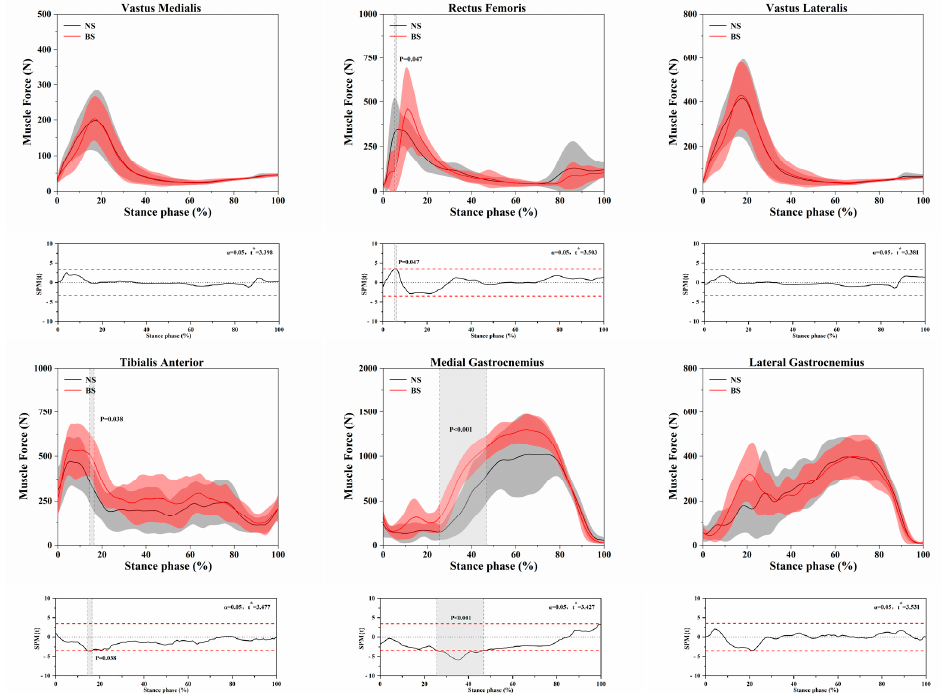
Figure 6. Illustration of the result between the NS and BS lower limb showing the statistical parametric mapping outputs for the medial gastrocnemius, lateral gastrocnemius, vastus medialis, vastus lateralis, rectus femoris, and tibialis anterior during the walking stance phase. The muscle force values of t* are shown on the left of each image. Grey shades represent the significant differences and the t -values of the SPM for all participants (post hoc results; dashed red lines represent the results at a p = 0.05 level). NSs, normal shoes; BSs, bionic shoes; N,